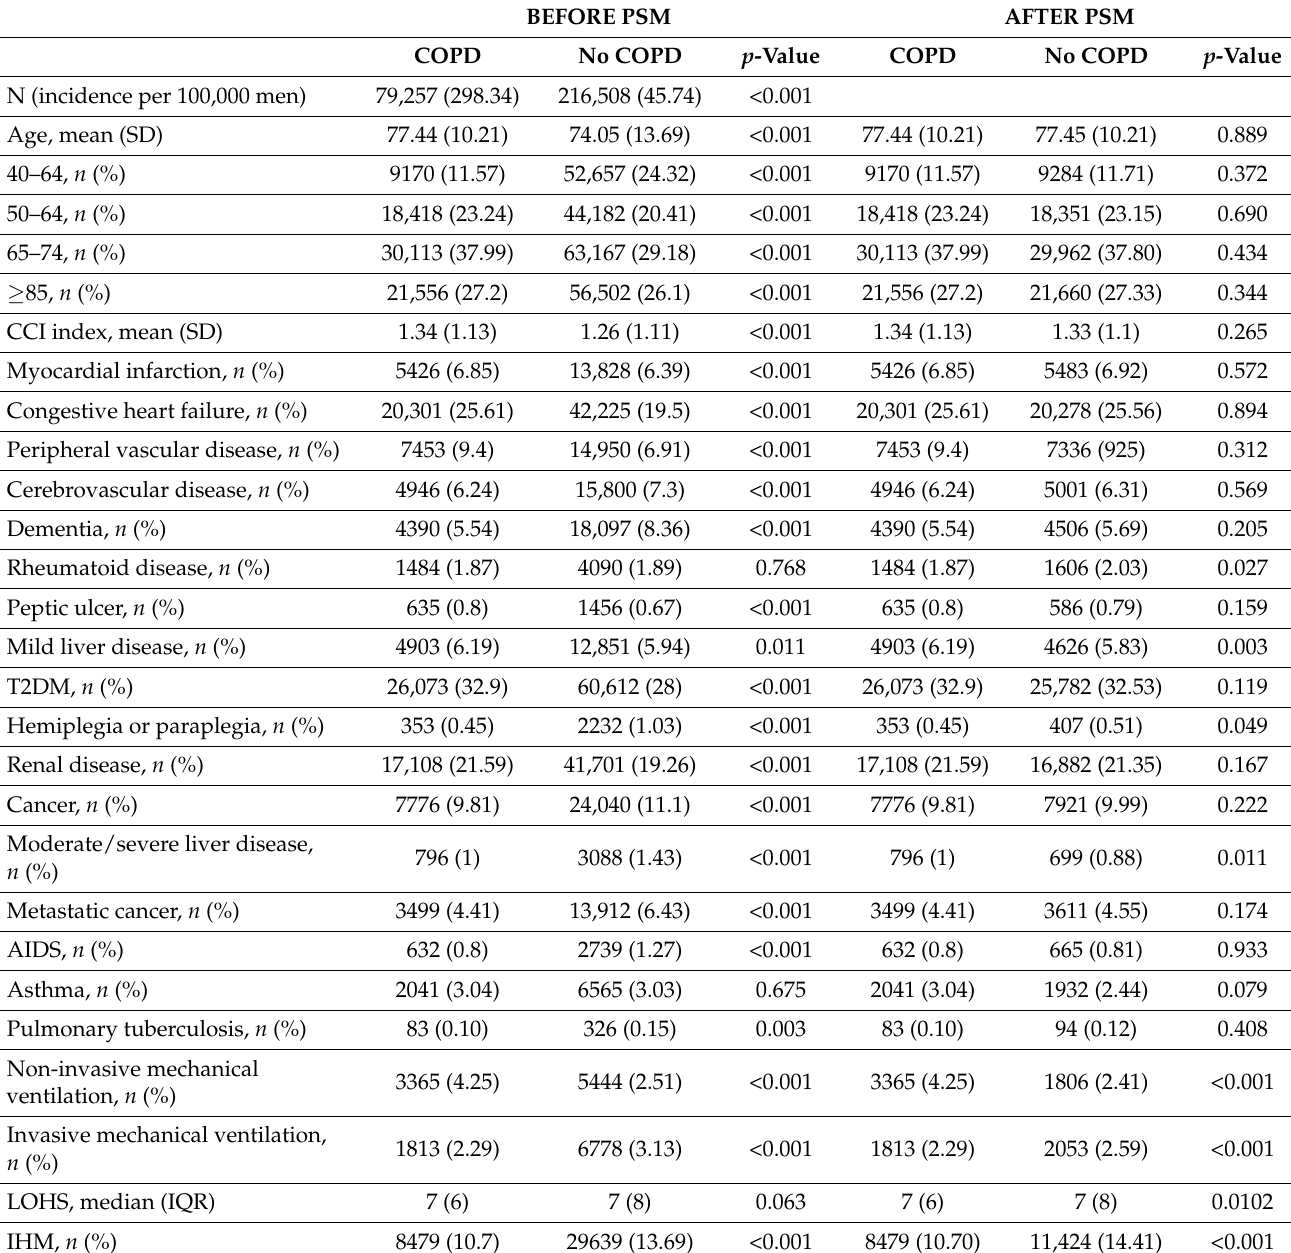
Table 3. Incidence, age distribution, Charlson comorbidity index, concomitant diseases, and hospital outcomes for men admitted to Spanish hospitals from the year 2016 to 2019 with community-acquired pneumonia according to presence of chronic obstructive pulmonary disease. Results before and after propensity score